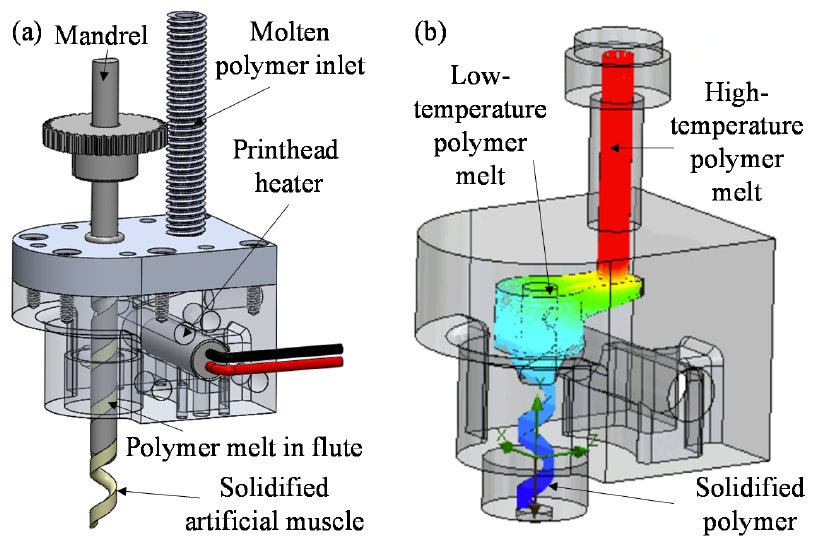
Figure 1. ( a ) Schematic of the printhead with the helical flute. ( b ) Temperature distribution of the printhead to control polymer